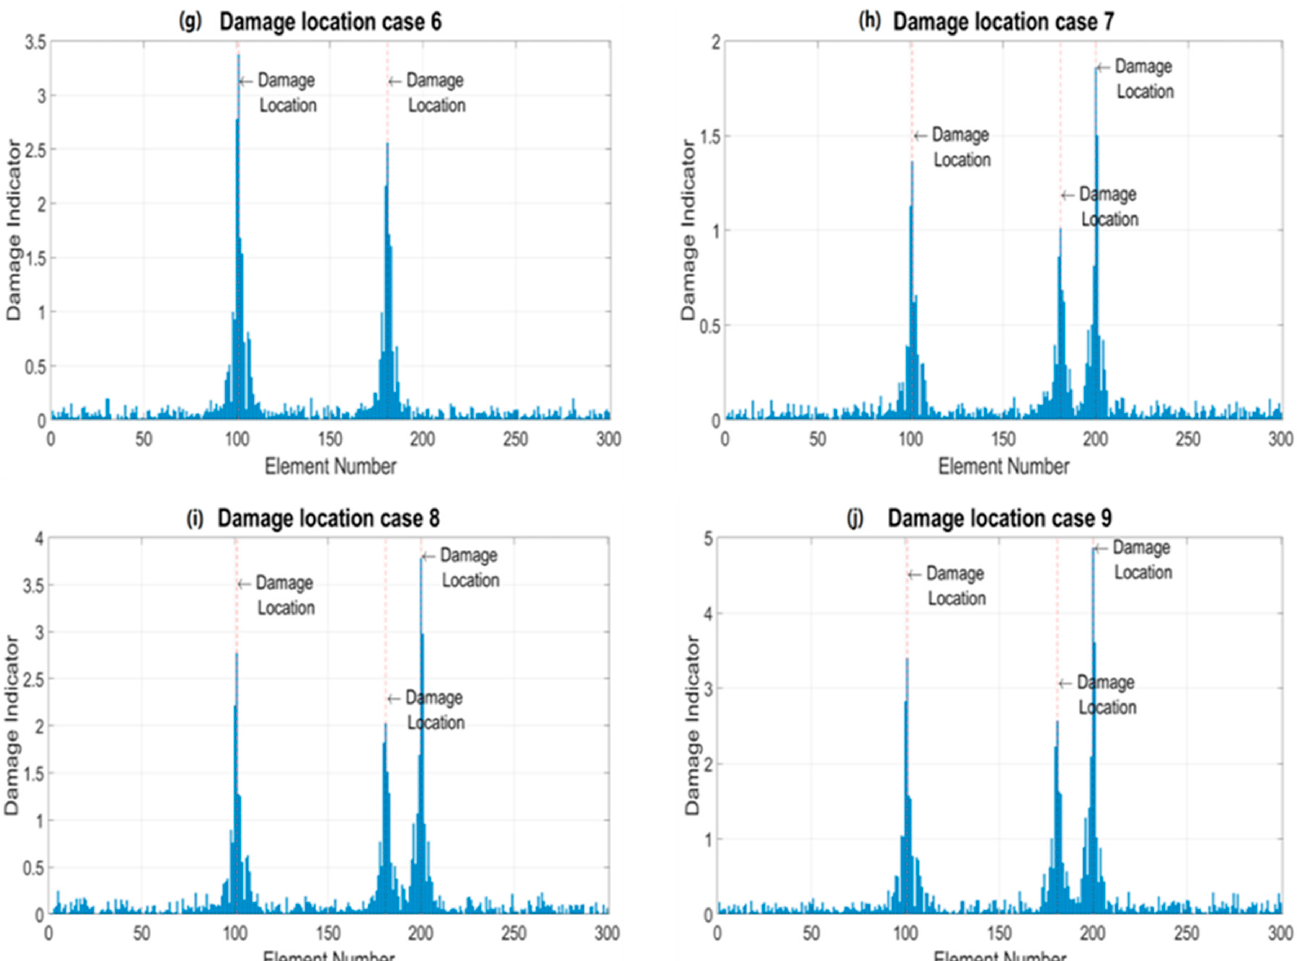
Figure 11. The damage location results for moving load having 6% white noise: ( a ) undamaged case; ( b ) case 1; ( c ) case 2; ( d ) case 3; ( e ) 4; ( f ) case 5; ( g ) case 6; ( h ) case 7; ( i ) case 8; and ( j ) case 9.